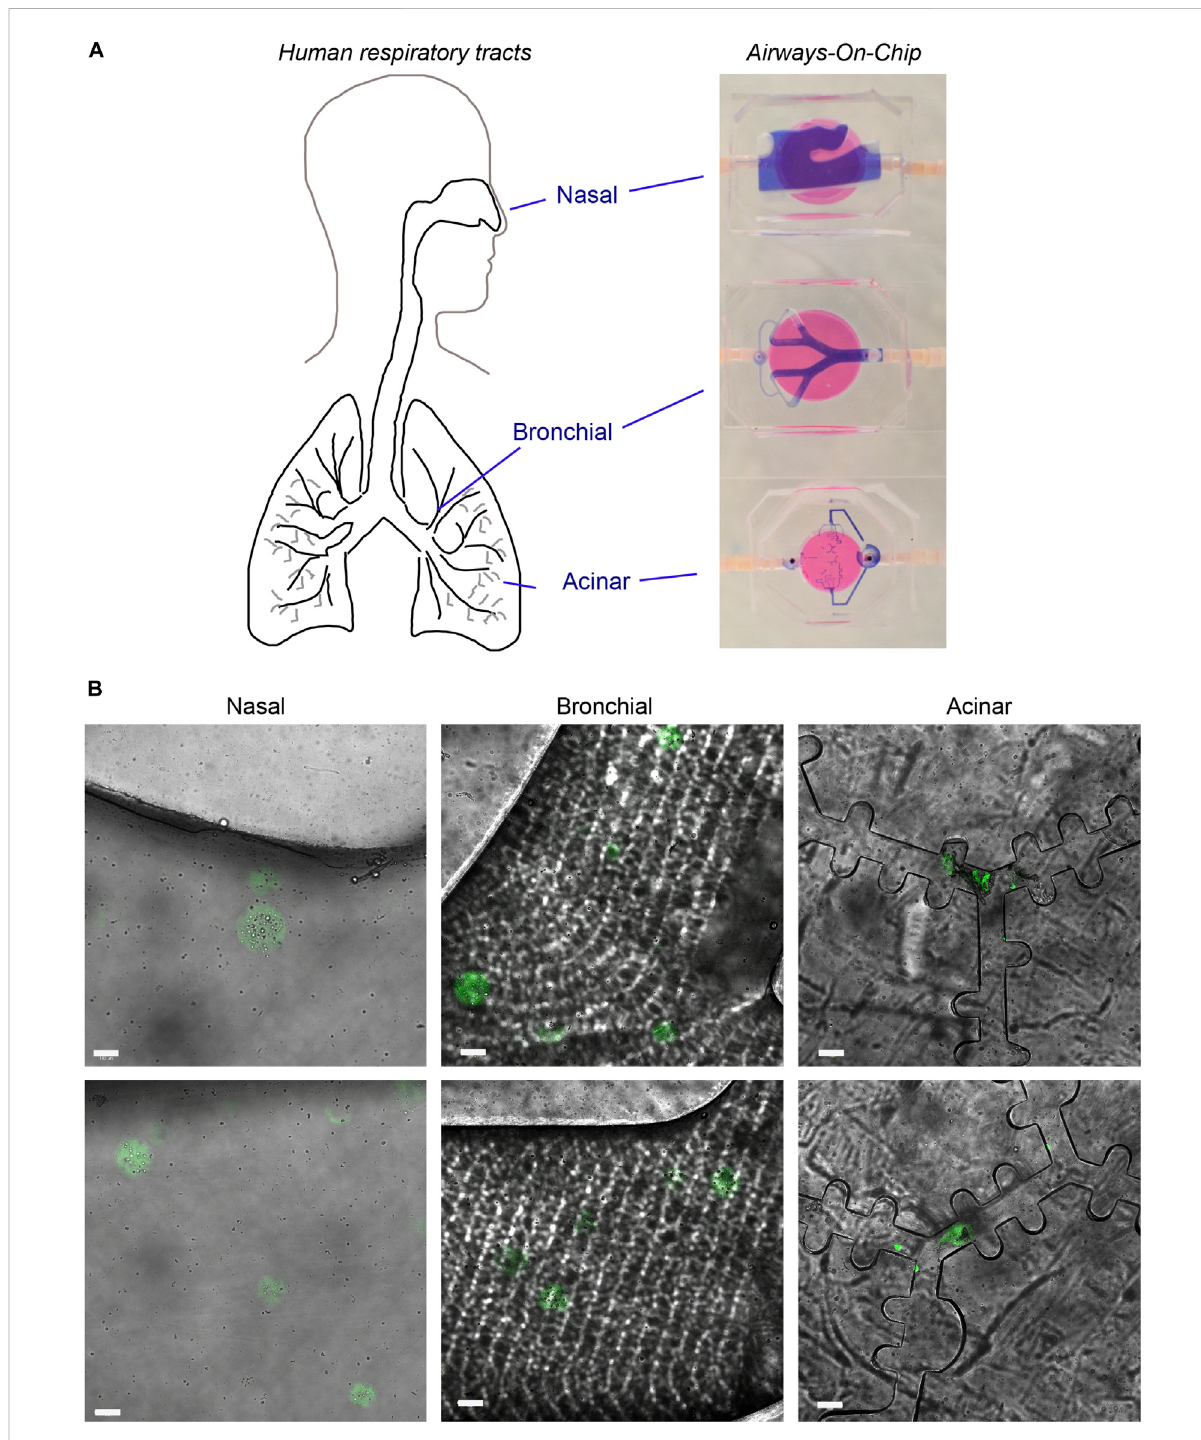
FIGURE 6 Microsphere deliveryto human respiratorytractmodels. (A) An illustrationofthehumanrespiratorytracts:nasal, bronchial and alveolar andthe parallelAirways-on-chipmodels.Themodelswereinjectedwithtrypanbluetodemonstratethe fl owinsidethecompartments. (B) Confocalimages of nasal, bronchial and alveolar compartments showing Calcein-stained microspheres (green). Two representative images from each compartment from three independent experiments are presented. Scale bar 100